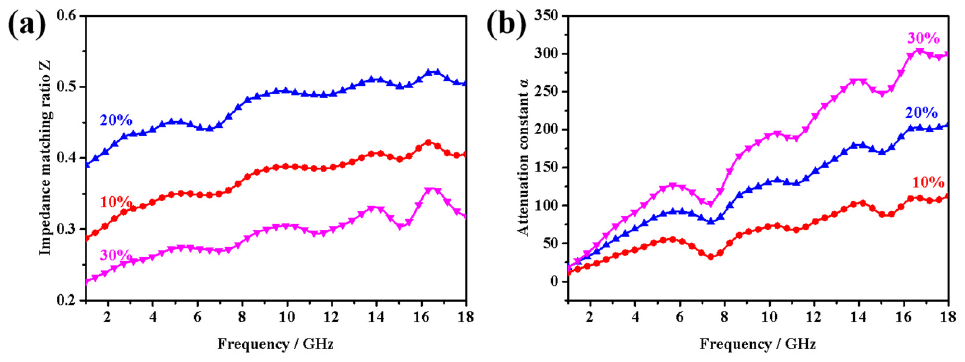
Figure 10. ( a ) The impedance matching ratio Z and attenuation constant α of the CoS 2 /paraffin com- posites with different filling contents. composites with different filling